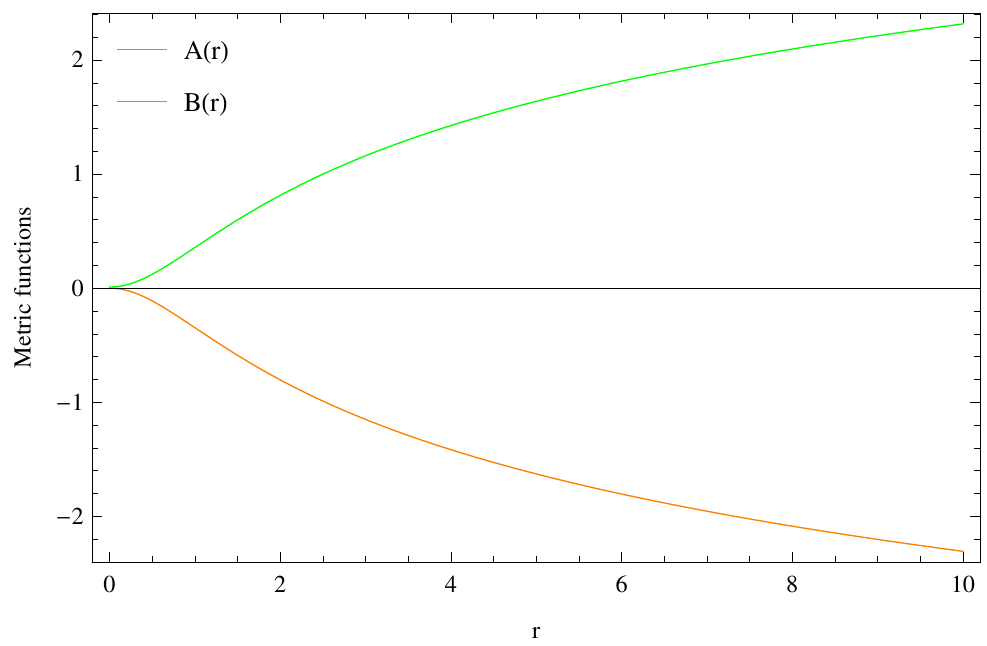
Figure 1. The metric functions for dark energy matter case, ω = − 1, are plotted against the radial parameter r , for the values of constants C 1 = 0.01, C 2 = 0.5.